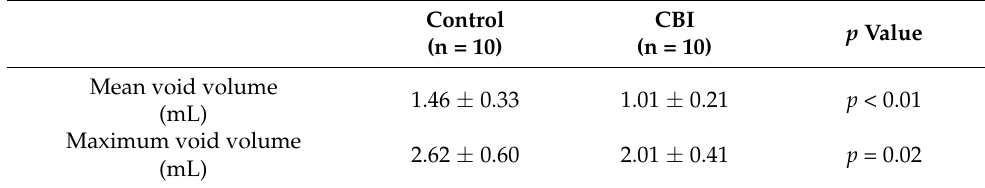
Table 1. Metabolic cage studies in the control and CBI